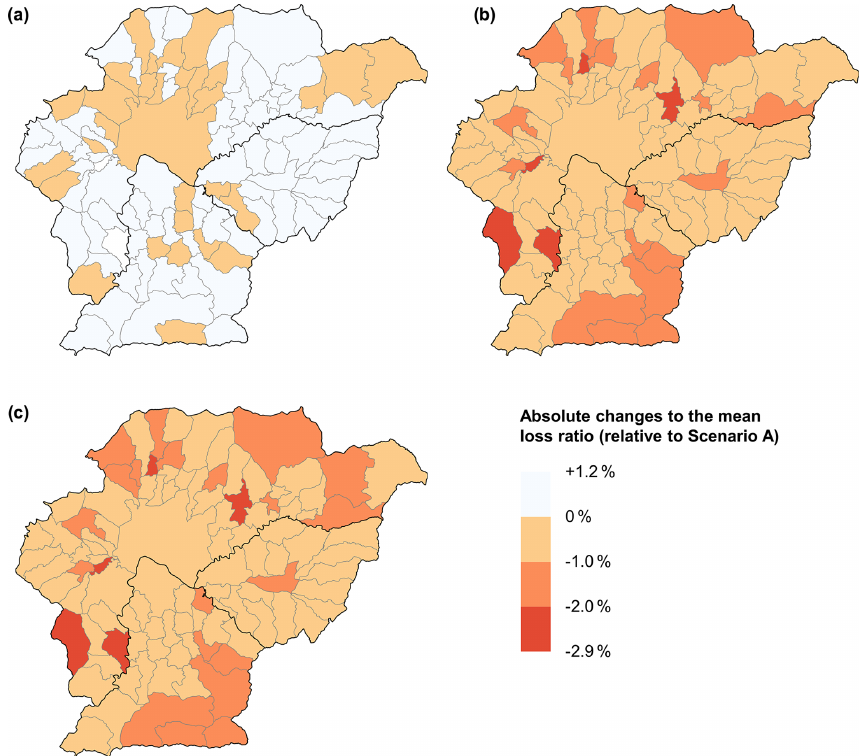
Figure 12. Absolute changes to the municipality-level mean loss ratios for (a) Scenario B, (b) Scenario C, and (c) Scenario D, relative to Scenario A, for the 100-year flooding